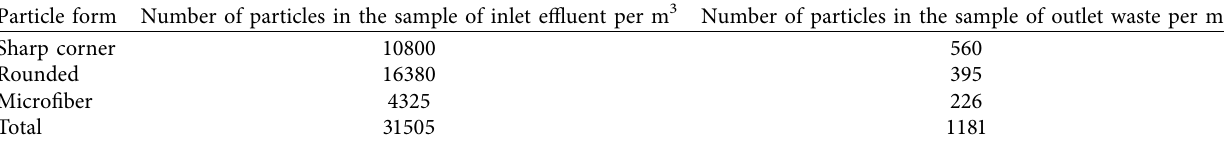
Table 4: Results of counting particles by appearance and type in summer.